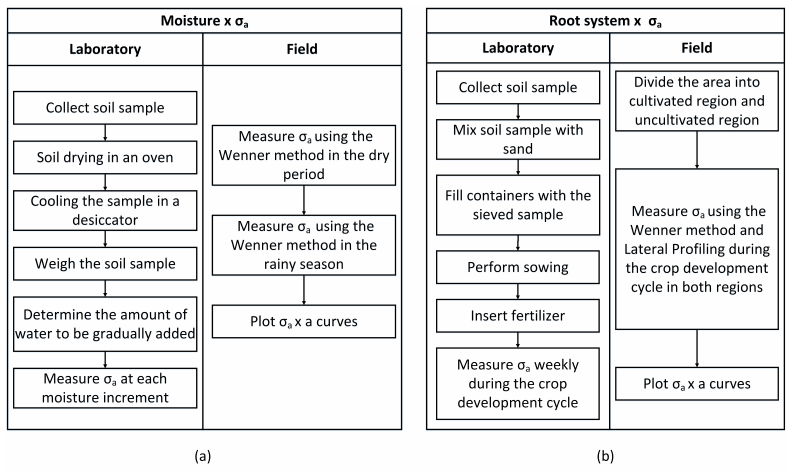
σ a and ( b ) relationship ×